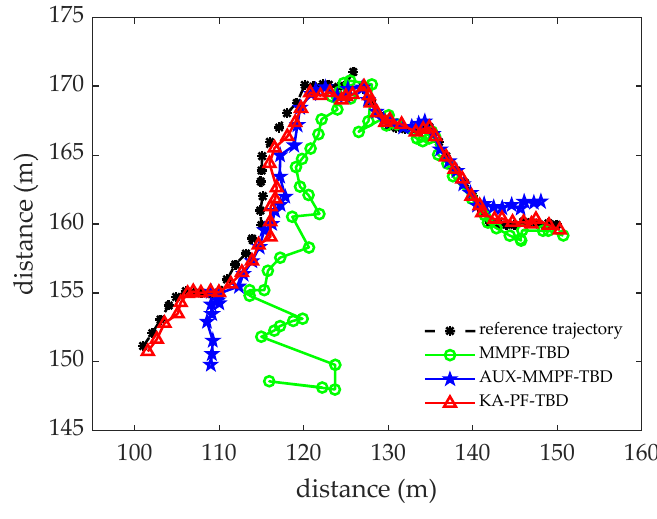
Figure 7. The tracking results.